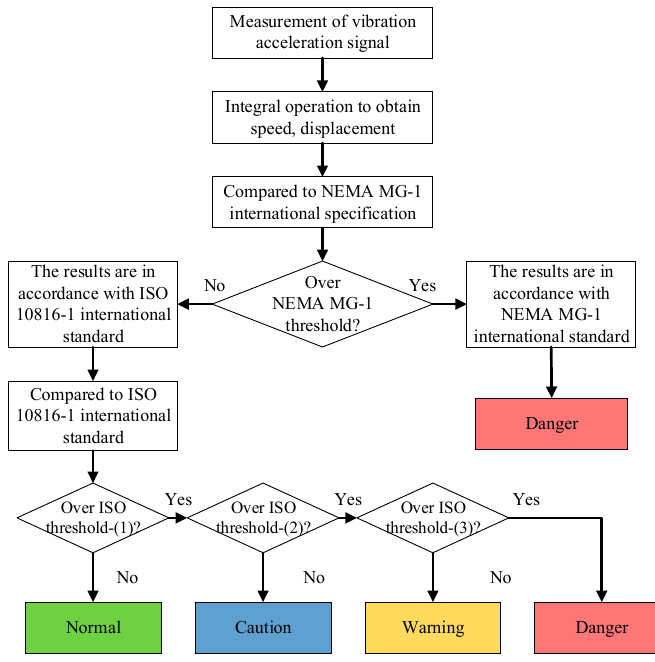
Figure 4. OCM module flow chart.